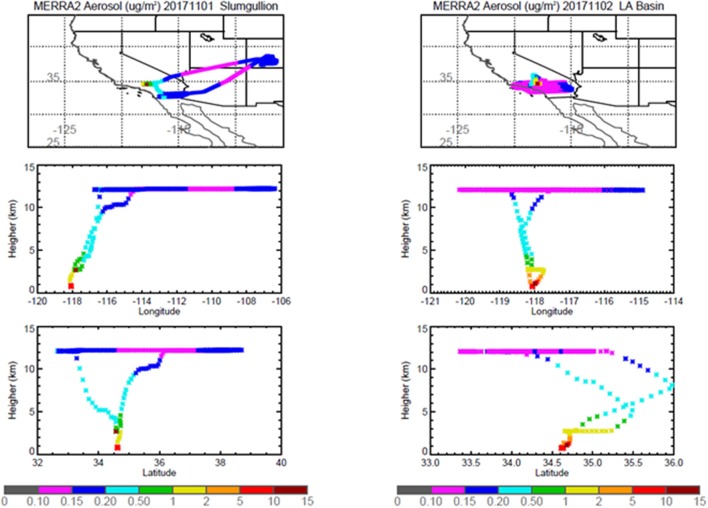
MERRA-2 results depicting bulk aerosol concentration (μg·m−3) for Slumgullion (Left) and LA Basin (Right) flights; top panel shows horizontal cross section and bottom panel shows vertical cross section.